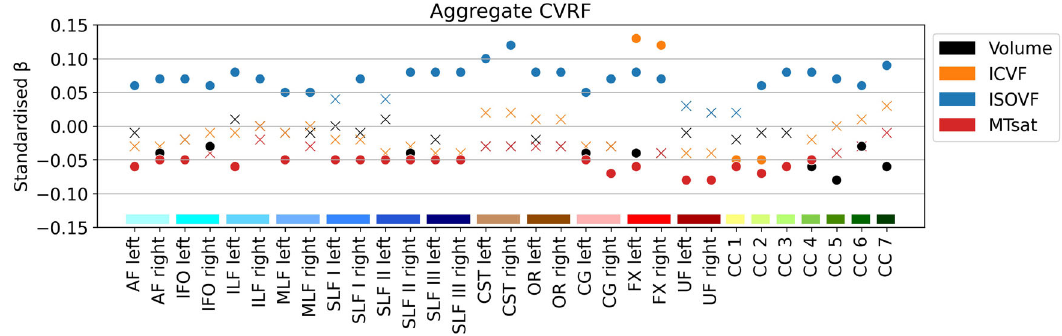
Fig. 4 White matter tract microstructure associations with the aggregate cardiovascular risk score ( n = 1104). Models were adjusted for age, age 2 , sex and total intracranial volume. MRI indices of tract-speci fi c axonal density (ICVF), free water (ISOVF), myelin content (MTsat) and tract volume were analysed. Standardised β s are shown as fi lled circles for signi fi cant associations (FDR-corrected p < 0.05) and as crosses for non-signi fi cant associations (FDR-corrected p ≥ 0.05). The x -axis contains the 31 tracts-of-interest coloured and grouped, as in Fig. 1, by association tracts (shades of blue), projection tracts (brown), limbic tracts (pink/red) and corpus callosum (yellow/green). AF arcuate fasciculus, CC corpus callosum (1 = rostrum, 2 = genu, 3 = rostral body, 4 = anterior midbody, 5 = posterior midbody, 6 = isthmus, 7 = splenium), CG cingulum bundle, CST cortico-spinal tract, CVRF cardiovascular risk factor, FX fornix, ICVF intra-cellular volume fraction, IFO inferior fronto-occipital fasciculus, ILF inferior longitudinal fasciculus, ISOVF isotropic volume fraction, MLF middle longitudinal fasciculus, MTsat magnetization transfer saturation, OR optic radiation, SLF superior longitudinal fasciculus, UF uncinate